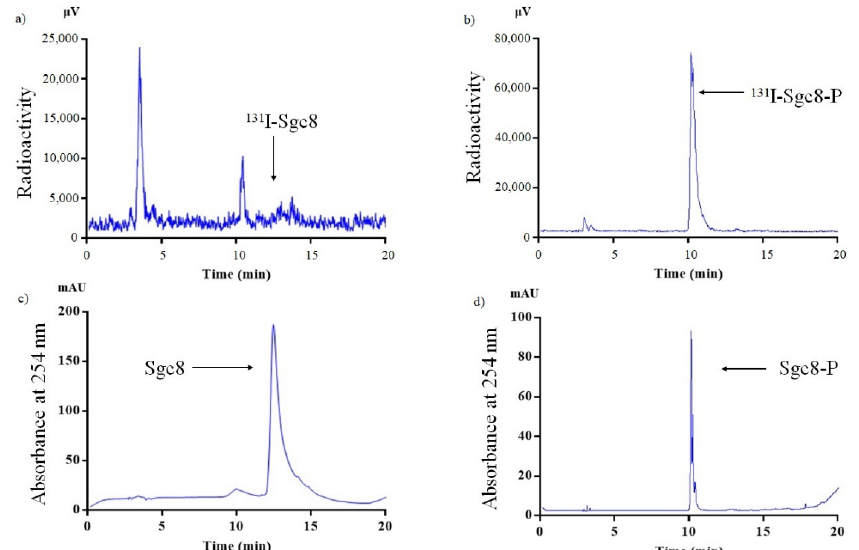
Figure 3. HPLC chromatogram analysis of Sgc8 ( c ), Sgc8-P ( d ), and the oligonucleotides after the treatment with classical radioiodination protocols ( a , b ).